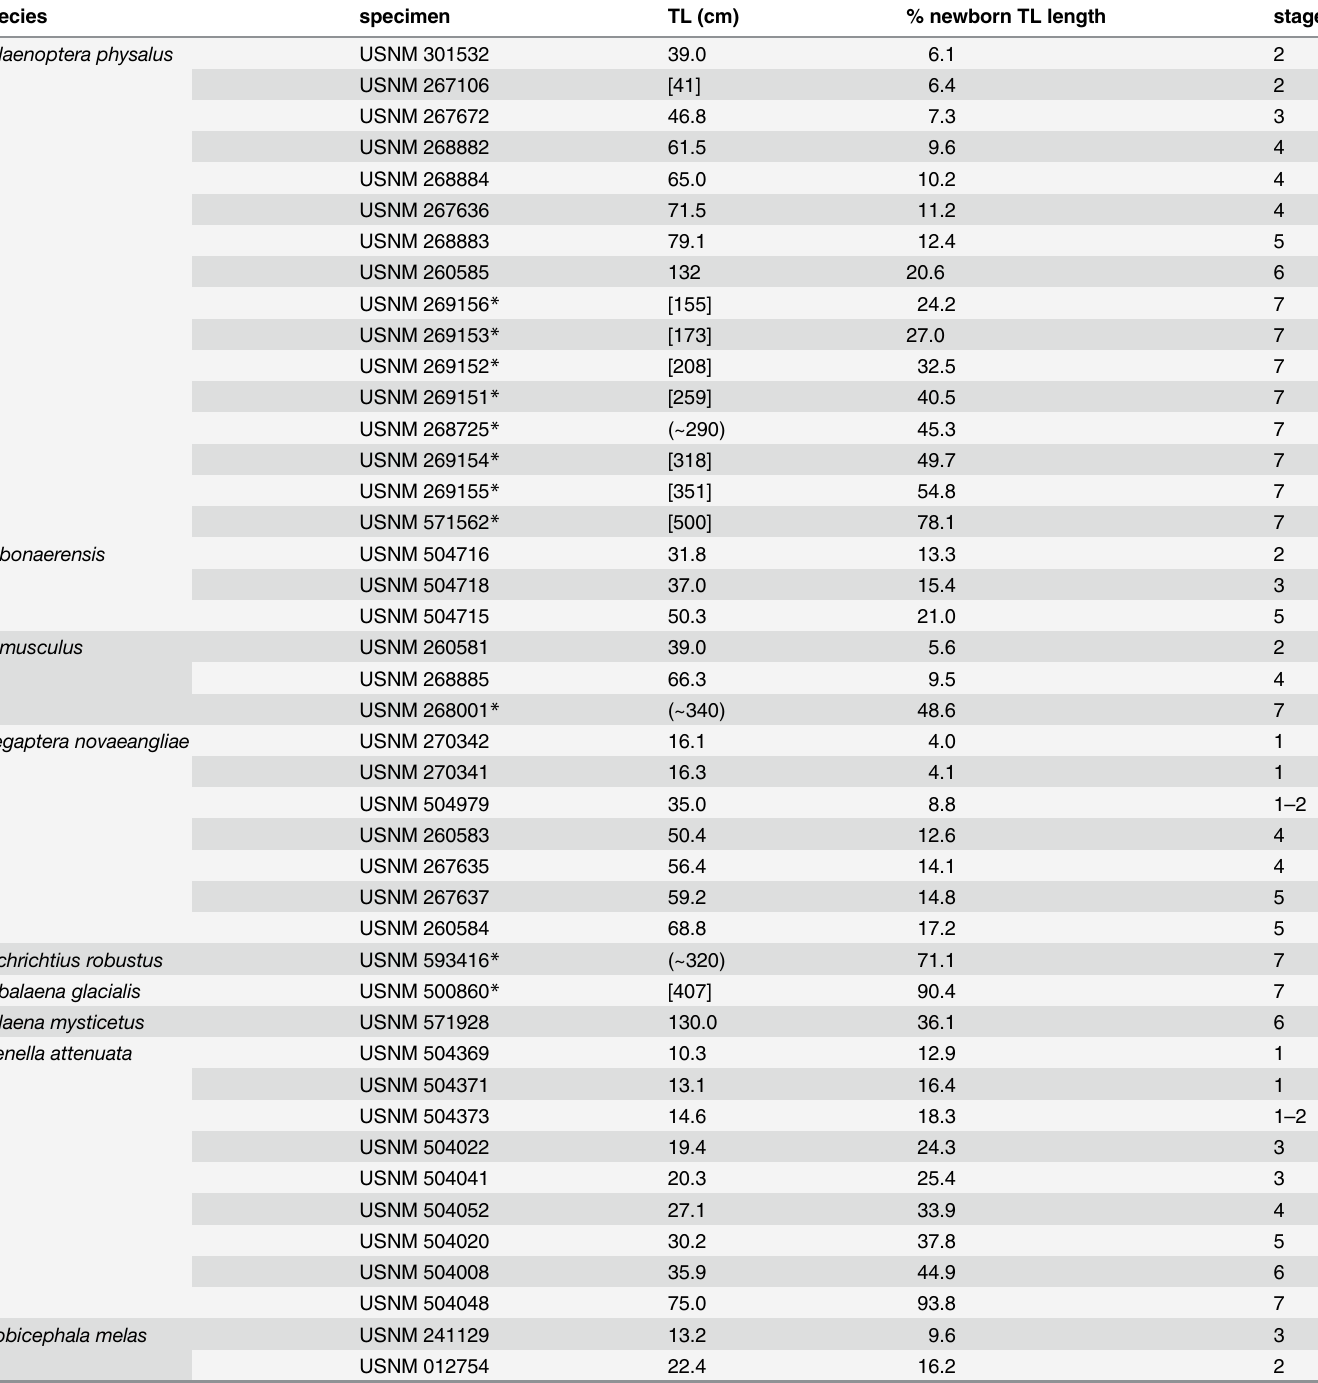
Table 1. Fetal cetacean specimens used in this study.